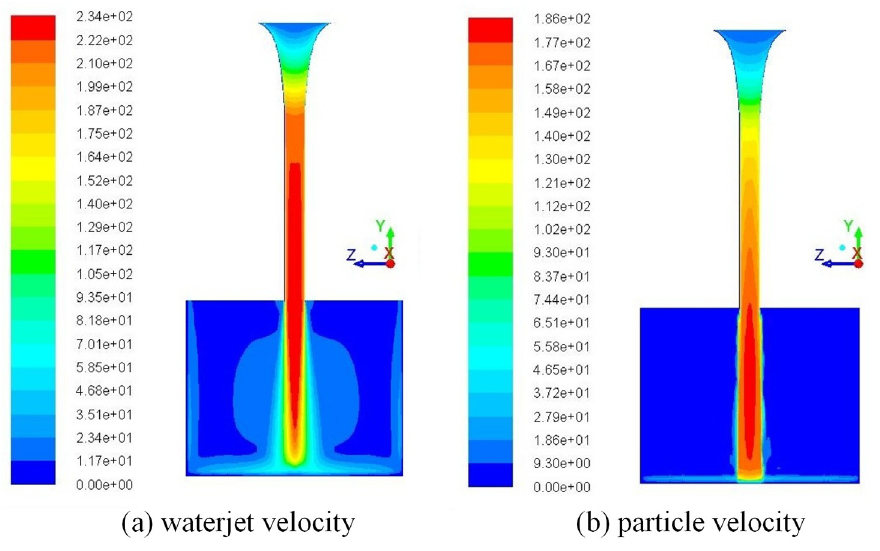
Fig 4. The distribution of particle velocity and waterjet velocity.